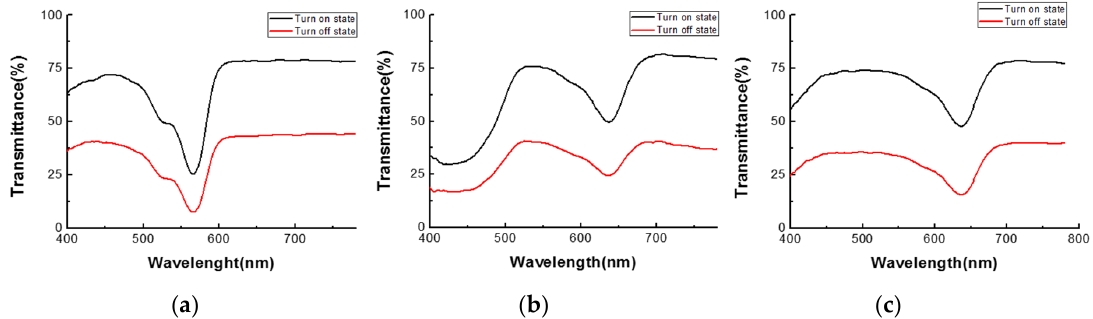
Figure 11. Transmission spectra of transmitted light in the on and off states of ( a ) red, ( b ) green, and ( c ) blue PDLC devices, respectively.